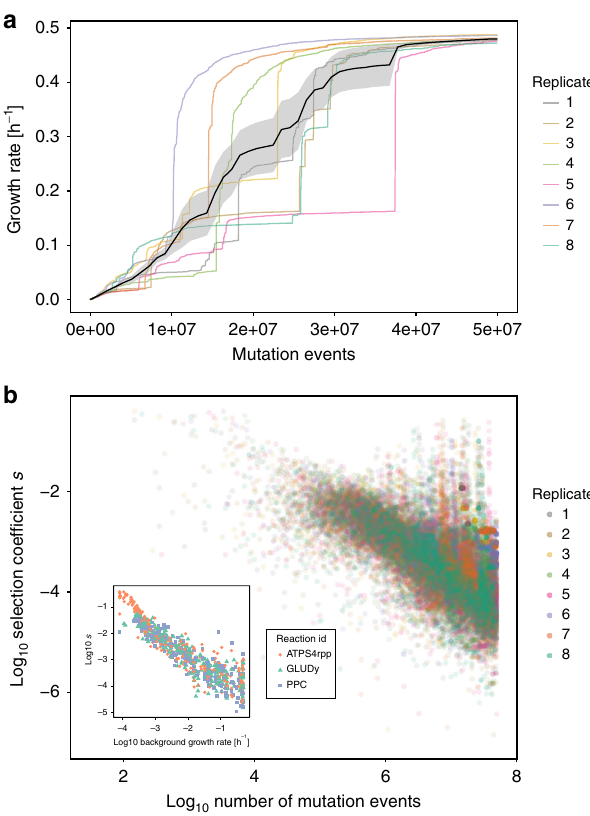
Fig. 2 Evolutionary trajectories exhibit convergence and diminishing returns epistasis. a The growth rate of the population against the number of simulated mutations. The black line shows the average growth rate across replicates and its standard error. The replicates showed 4880 fi xation events on average. See Supplementary Figure 3 for a fi t of the analytical model presented in Supplementary Note 1. b The selection coef fi cient s (de fi ned as the change in growth rate relative to the novel growth rate) plotted against the cumulative number of simulated mutational events for all fi xed mutations. The inset shows s against the background growth rate in which a mutation occurred for the three reactions that had the most changes in k cat fi xed. These reactions are: ATPS4rpp: ATP synthase (orange), GLUDy: Glutamate dehydrogenase (NADP) (green), and